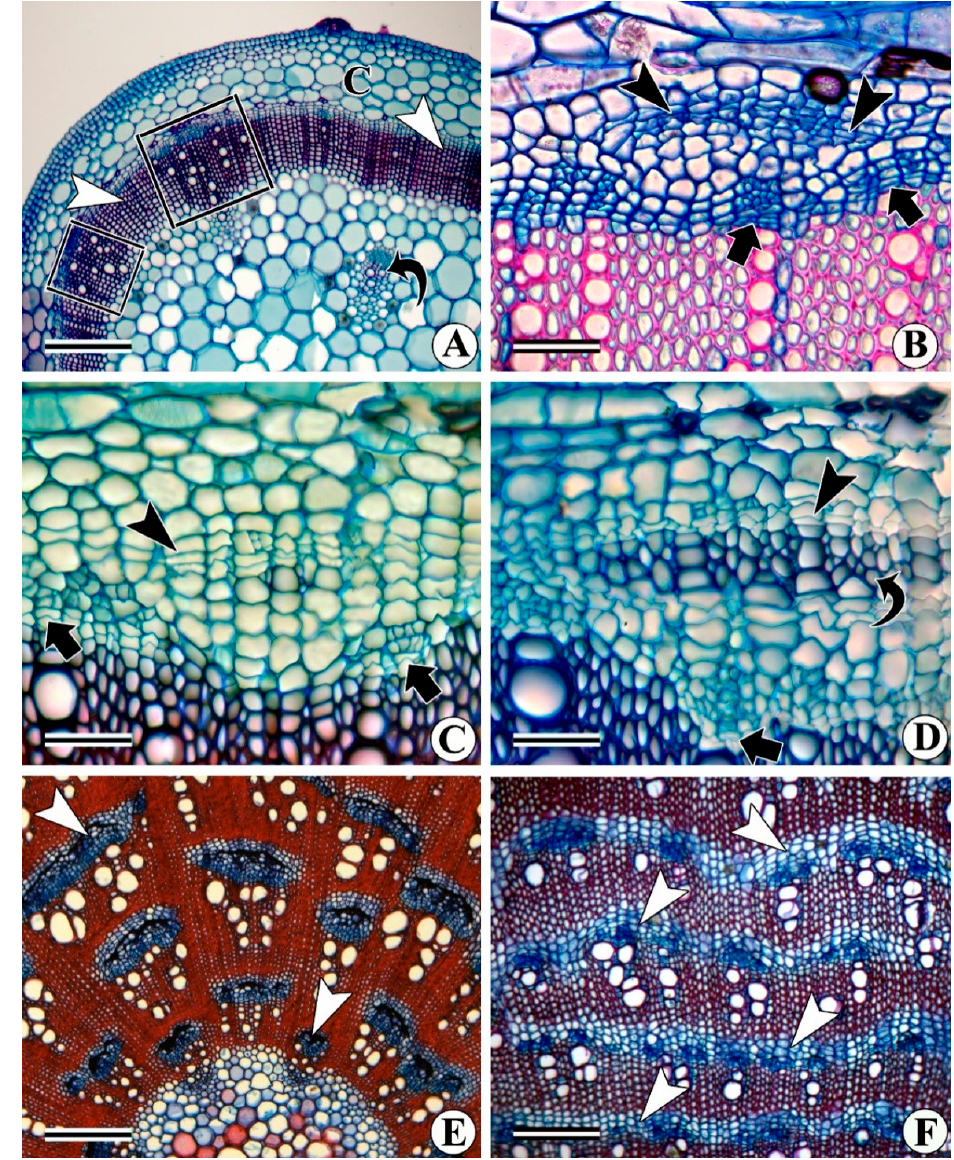
Figure 18. Transverse view of stem showing various stages of phloem development in different members of the Caryophyllales family. ( A ) Establishment of the regular vascular cambium in Cyathula prostrata showing a completely formed xylem ring. Differentiation of the xylem and phloem is restricted to a certain portion of the cambium (rectangles), whereas alternate segments show only the development of fibres (arrowheads). The curved arrow indicates the medullary bundle. ( B–D ) Development of coalescent cambium (arrowhead); arrow(s) indicate the ceased portion of the cambium in Nothosaerva brachiata , Allmania nodiflora, and Alternanthera sessilis, respectively. The curved arrow in Figure 18D indicates the products of the newly formed cambial segment. ( E ) Thick stem of Hebanthe paniculata showing previously formed phloem islands and coalescent phloem parenchyma (arrowheads) embedded within the lignified elements. Note that the formation of the xylem and phloem is restricted to a certain portion of the cambium and the gradual increase in the tangential width of the coalescent cambium. ( F ) Complete successive ring (arrowheads) formation externally in thick stems of Aerva sanguinolenta . Scale bars : A, E = 200 µm; B–D = 50 µm; F = 100 µm.